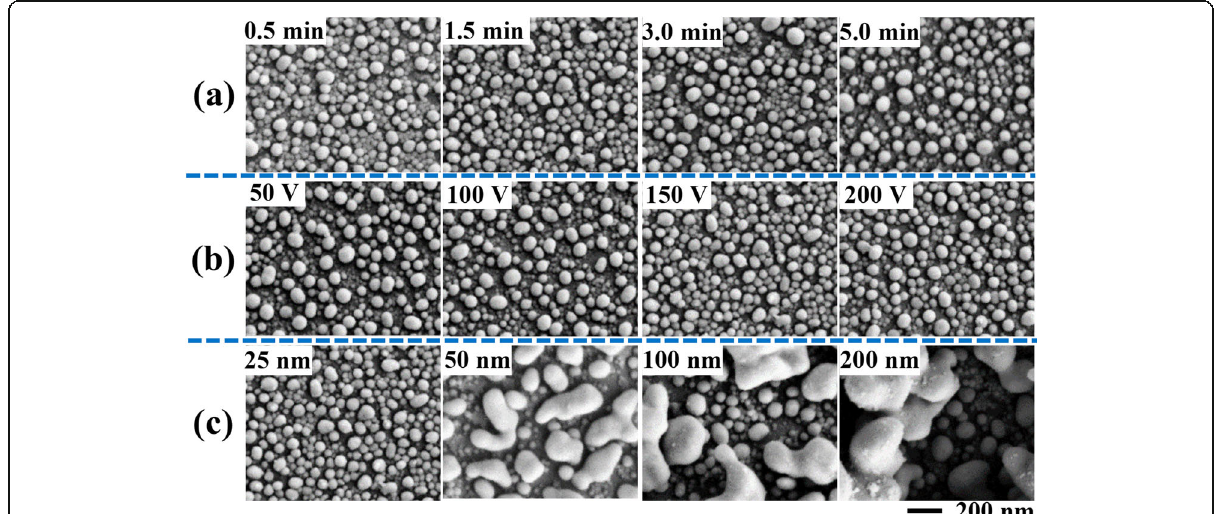
Fig. 3 Fabrication of NDs under various experimental conditions by varying a reaction time, at a constant applied voltage of 150 V and ITO film thickness of 25 nm, b applied voltage, at constant ITO film thickness of 25 nm and reaction time of 1.5 min, and c ITO film thickness, at constant applied voltage of 150 V and reaction time of 1.5